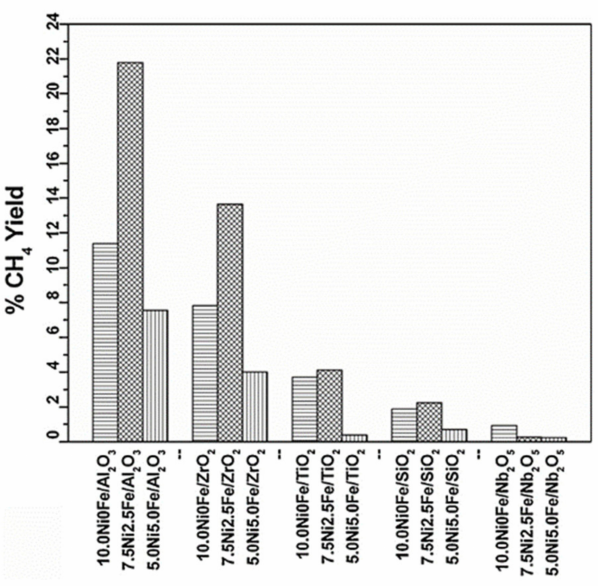
Figure 6. CH 4 yield for Al 2 O 3 , ZrO 2 , TiO 2 , SiO 2 , and Nb 2 O 5 supported Ni and series of Ni–Fe bimetallic alloy catalysts at 250 ◦ C. Catalytic measurements were done in fixed bed flow reactor at 250 ◦ C on 150 mg under continuous flow of 4% v/v CO 2 in H 2 (80 mL min − 1 ) after reductive treatment (4 h in a flow of H 2 at 500 ◦ C) of the calcined samples (reprinted from Ref [124] © 2006, Elsevier